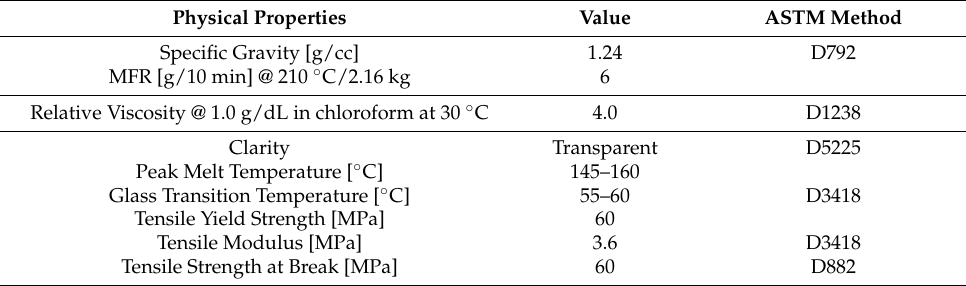
Table 1. Physical properties of PLA used to produce the